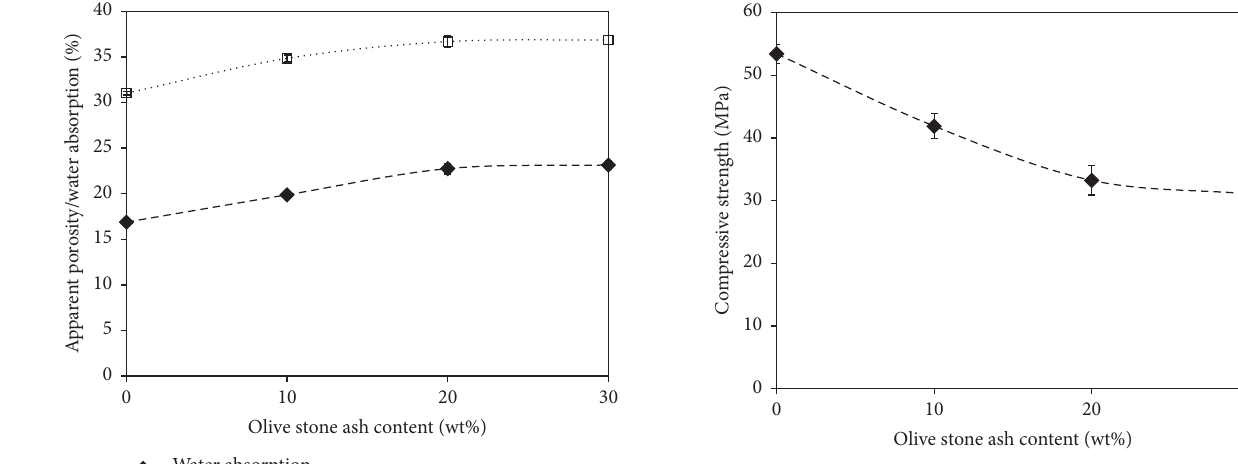
Figure 8: Compressive strength of the fired bricks as a function of olive stone ash